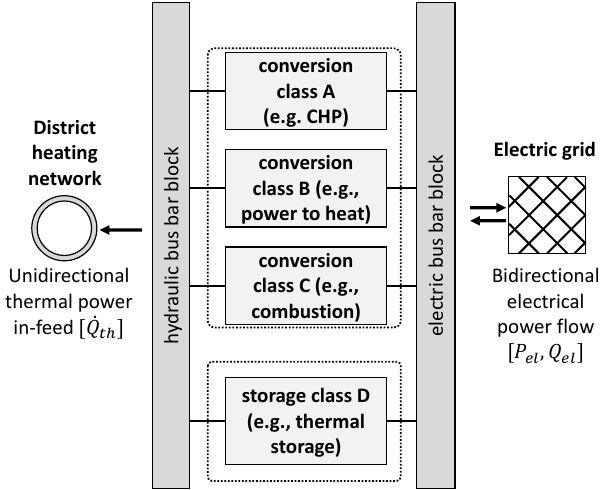
Figure 2. Abstract perspective on key elements of the architecture: energy conversion and storage units are modularized and can easily be snapped into the platform to connect to different